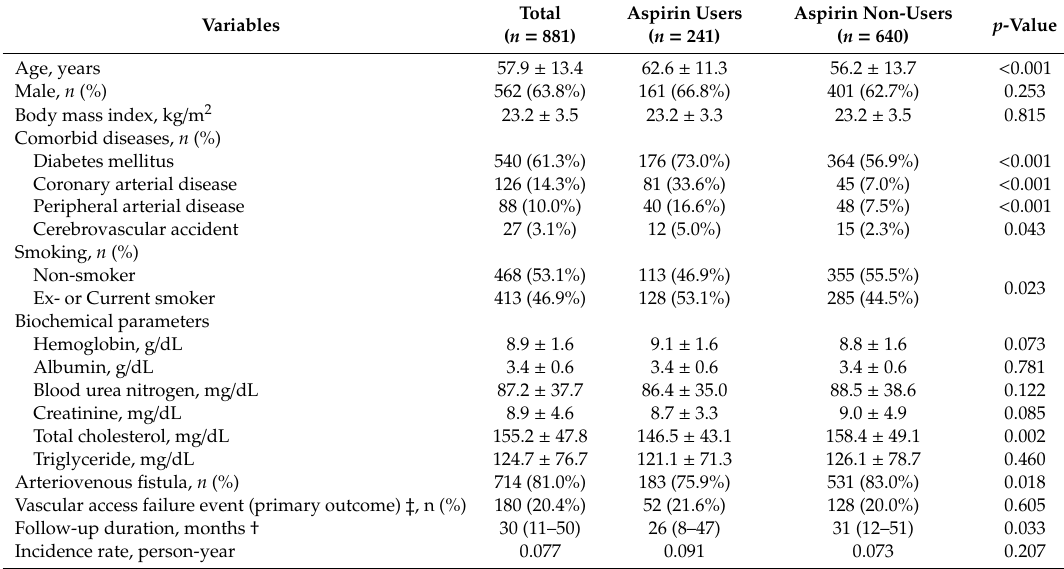
Table 1. Baseline clinical characteristics and biochemical variables of the study population according to baseline aspirin